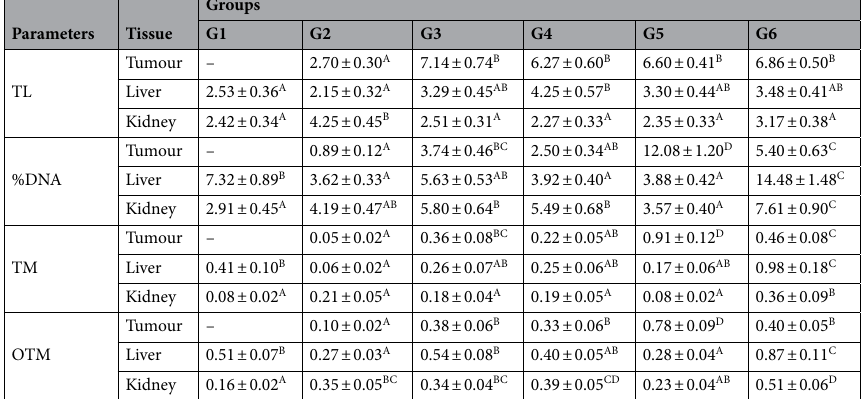
Parameters Tissue